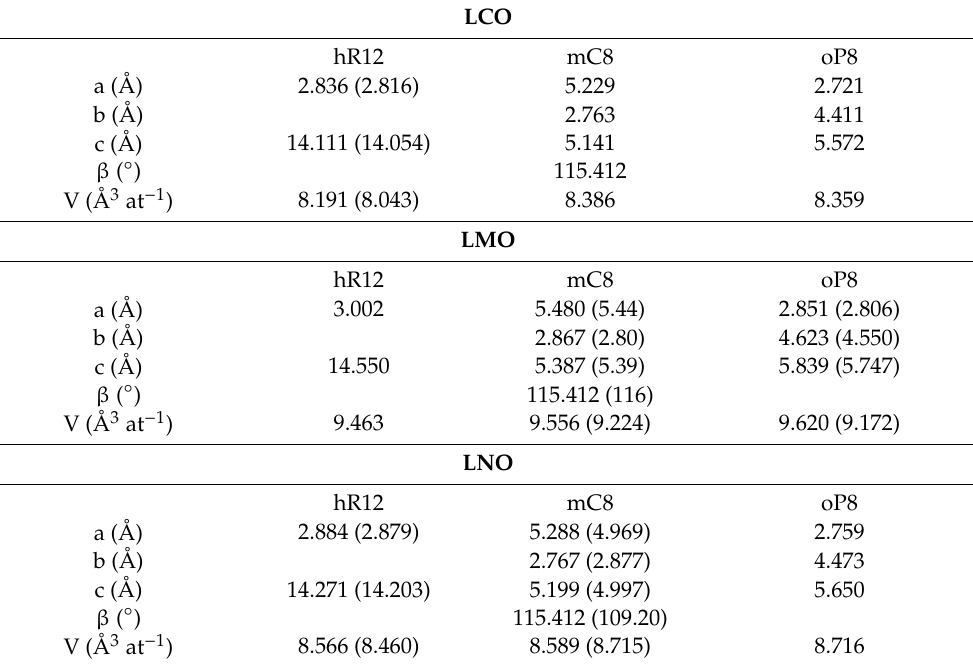
Table 1. Calculated lattice constants for the equilibrium structures, volumes and bond widths (referred to the monoclinic structure) for LiCoO 2 (LCO), LiNiO 2 (LNO) and LiMnO 2 (LMO). In parentheses, experimental values for the stable structures are reported for comparison